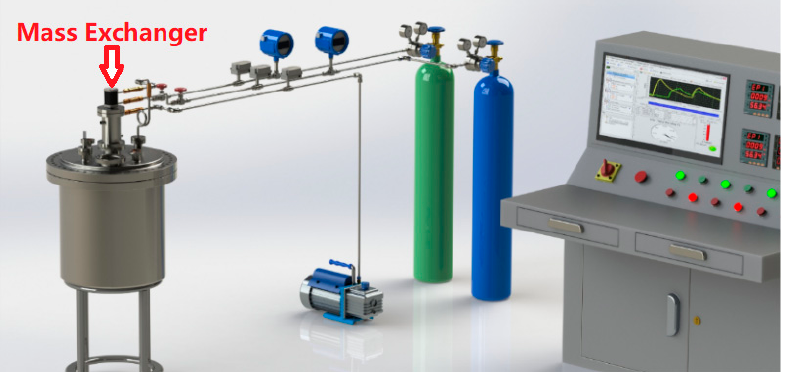
Figure 4. The experiment bench of the oxygen control system.